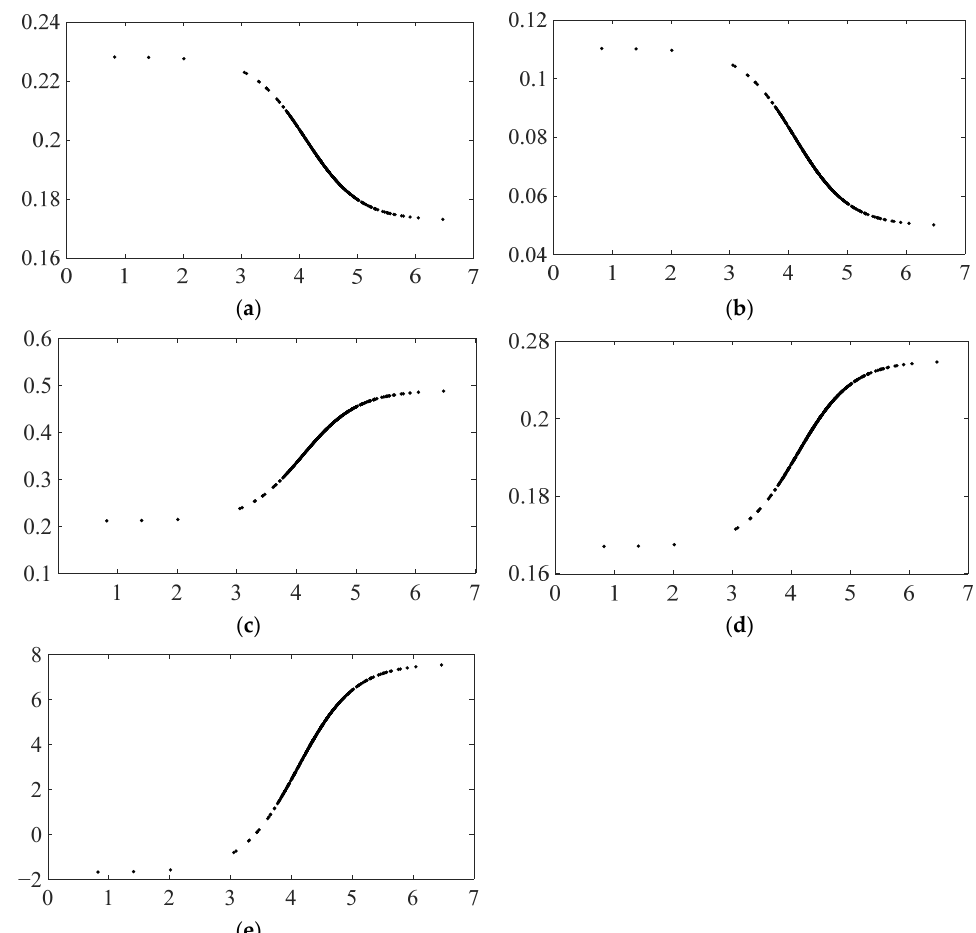
Figure 1. Nonlinear effects of EPU shocks on carbon emissions. Subplots ( a , b ) are a scatter plot and function plot, respectively.